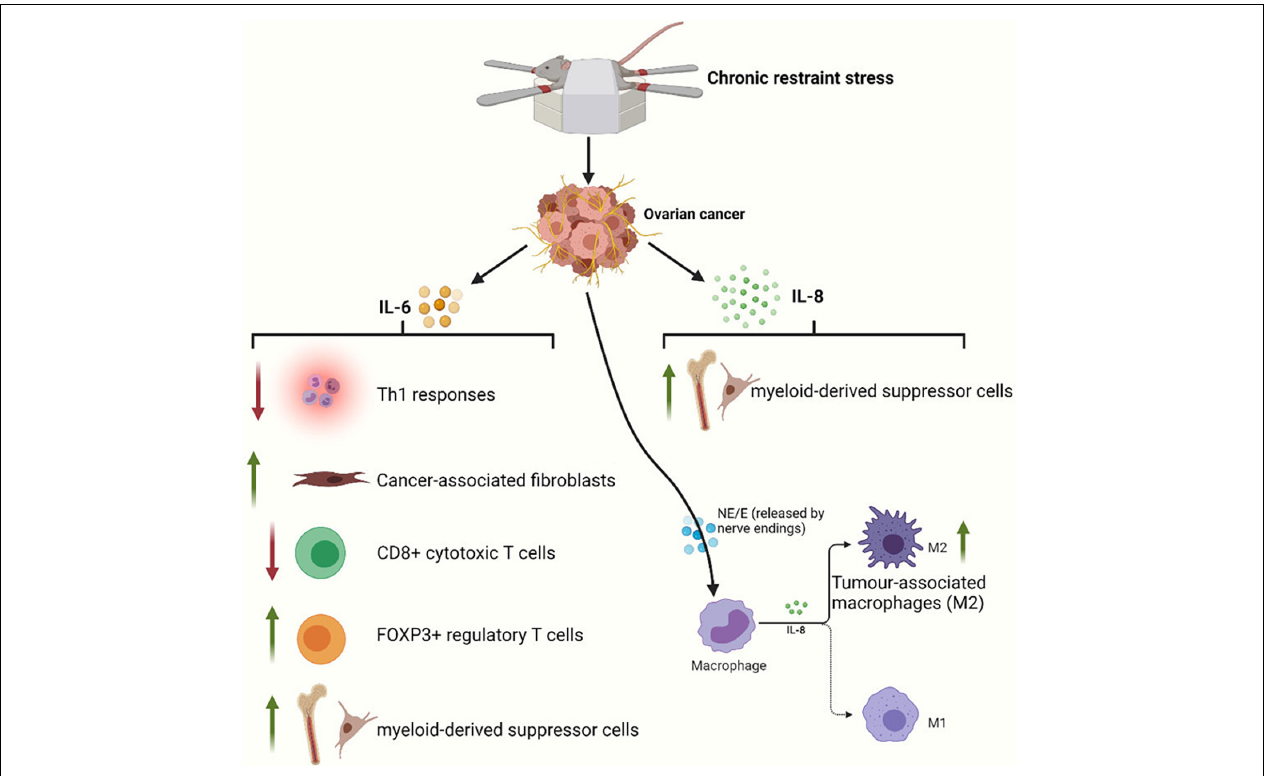
FIGURE 4 | Restraint stress can act through a variety of immune mechanisms to promote tumor progression. IL-6 released by ovarian cancer cells can inhibit adaptive antitumor immunity by suppressing Th1 responses and CD8 + T cell activation and by driving and recruiting regulatory T cells. IL-6 also initiates cancer-associated fibroblast and MDSC infiltration of the tumor microenvironment. IL-8 released by ovarian cancer cells can inhibit innate immunity by polarizing macrophages toward a type 2 tumor-associated phenotype and by supporting MDSCs into the tumor microenvironment. NE and E also exacerbate the infiltration of M2 macrophages via β 2-adrenergic receptors on